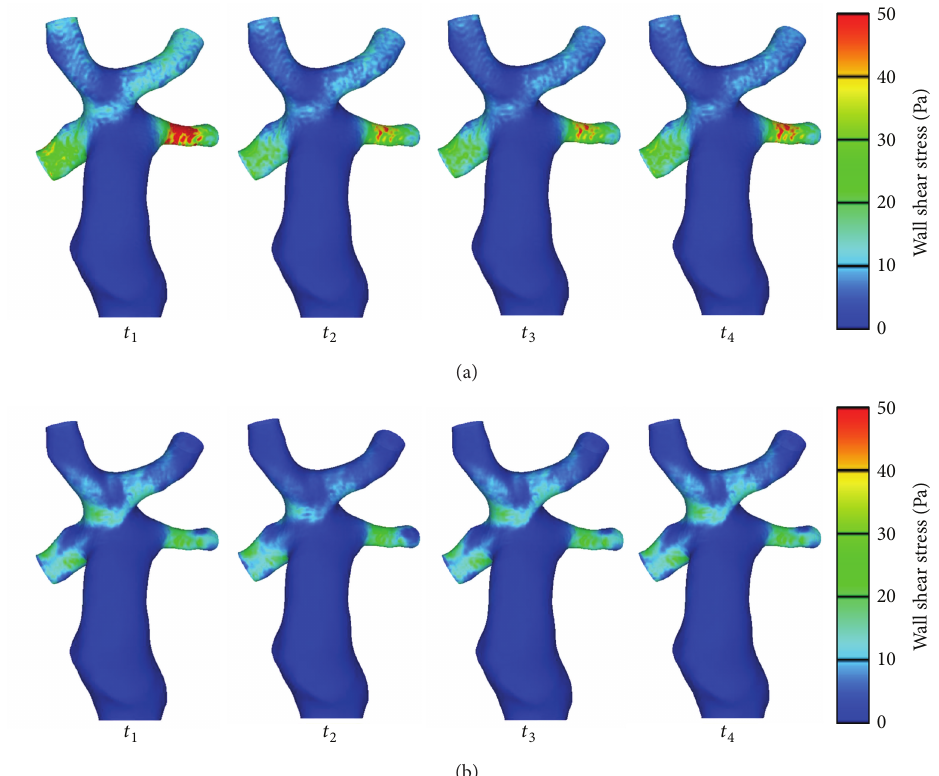
Figure 8: Results of wall shear stress (Condition II (a) and Condition I